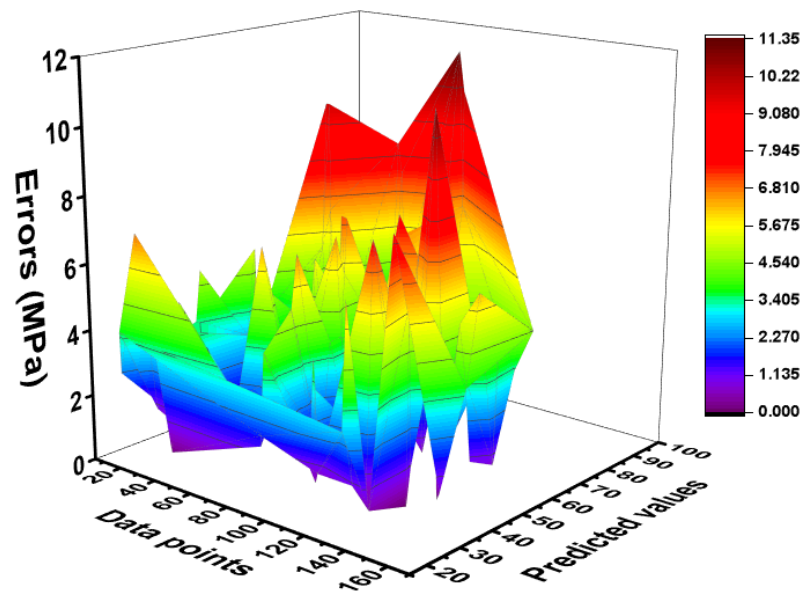
Figure 9. Error graphs of training set of MEP model.